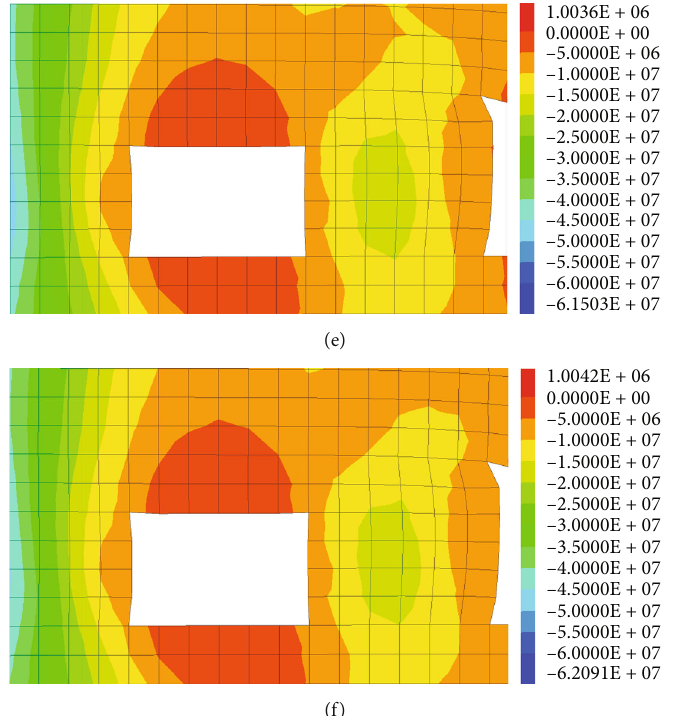
Figure 9: The evolution law of vertical stress of surrounding rock at roadway mileage y = 15 m : (a) 1m behind the heading face: (b) 2m behind the heading face; (c) 3 m behind the heading face; (d) 4 m behind the heading face; (e) 5m behind the heading face; (f) 6 m behind the heading face.